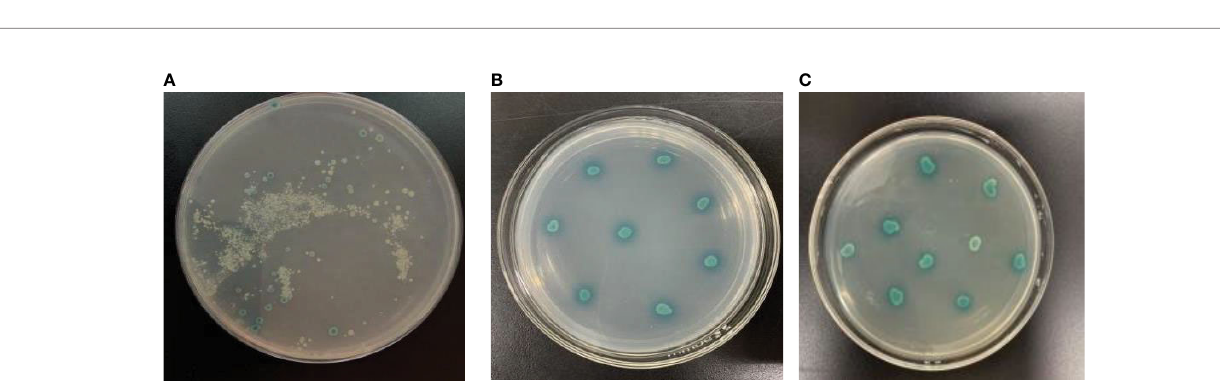
FIGURE 12 | Screening of positive colonies. The positive colonies were restreaked for three times on SD/-Ade/-His/-Leu/-Trp/X- a -Gal/AbA plates. (A) The initial screening. (B) The second screening. (C) The third